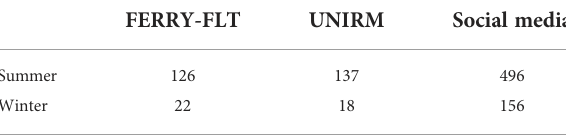
TABLE 1 Total number of common bottlenose dolphins recorded by the two research programs [onboard ferries FLT Net (FERRY-FLT) and a dedicated survey platform UNIRM)] and by social